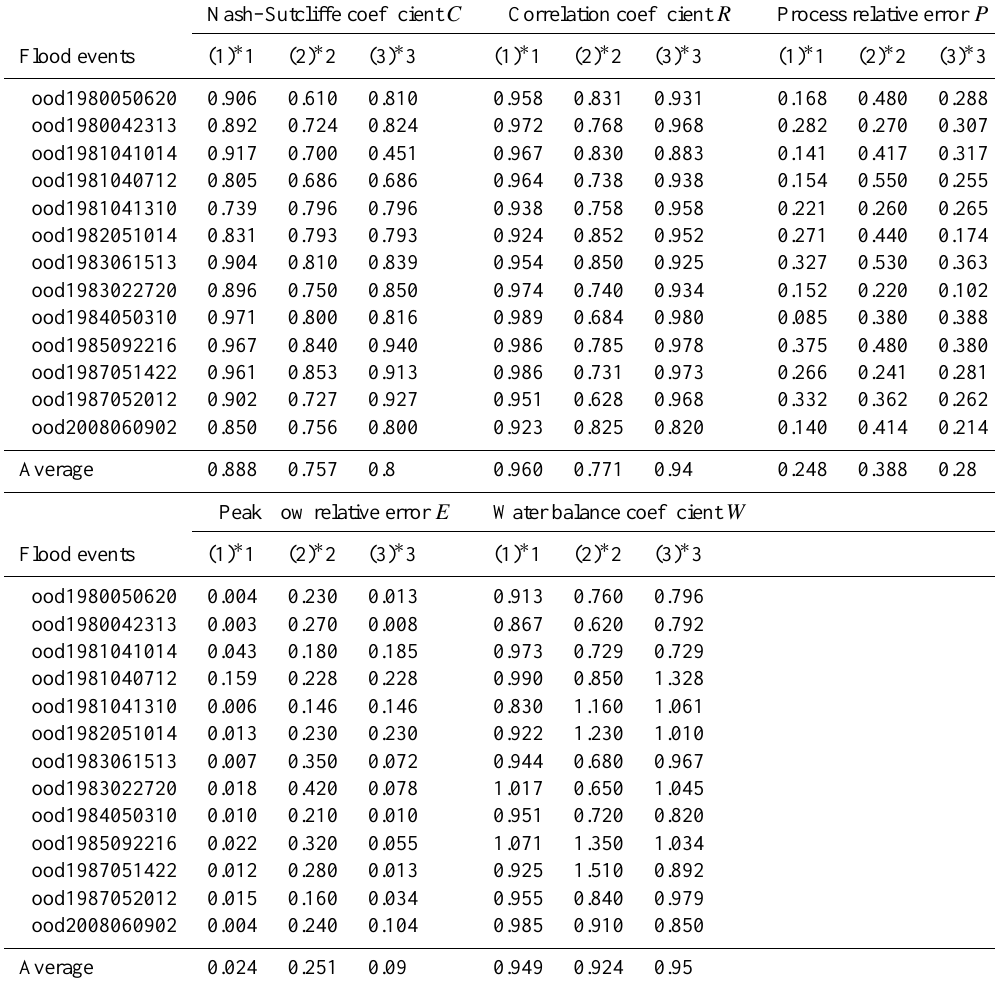
Table 7. The evaluation index of the simulated flood events in